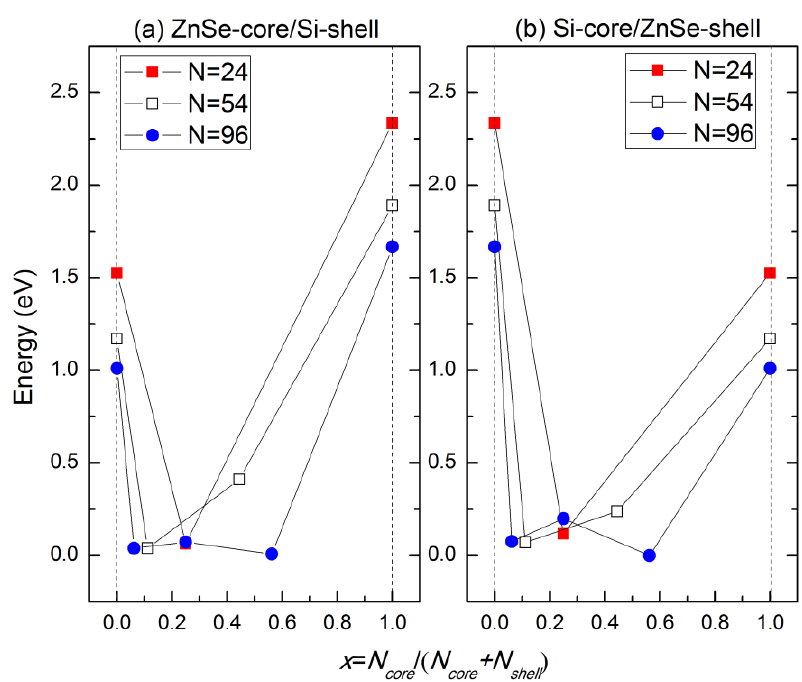
Figure 6. Variation of the band gaps of ( a ) ZnSe-core/Si-shell and ( b ) Si-core/ZnSe-shell NWs with the ratio of core